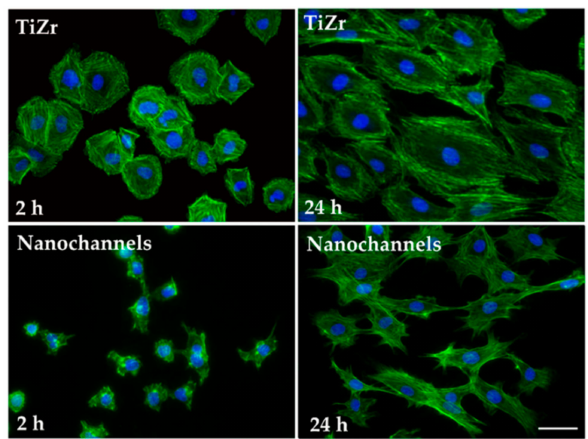
Figure 4. Fluorescence micrographs of MC3T3-E1 pre-osteoblasts in contact with the flat and nanochannelar TiZr samples for 24 h. The cells are labeled for F-actin (green) and nucleus (blue). Scale bar represents 50 µ